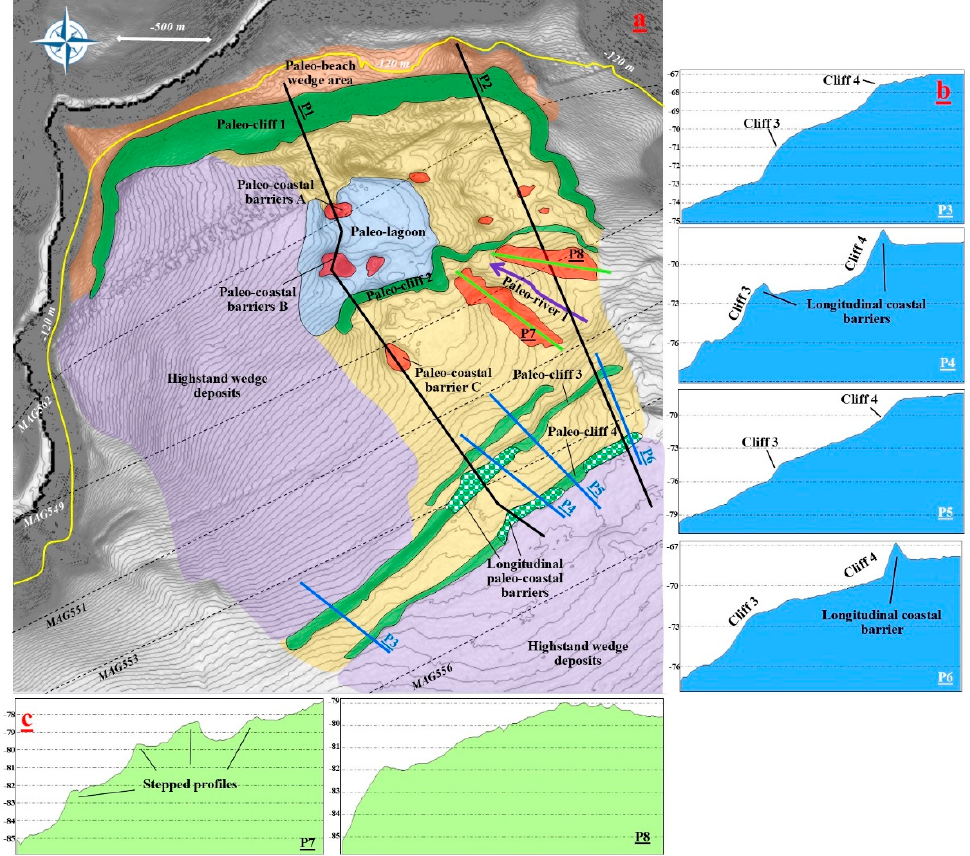
Figure 4. ( a ) Mapping of the main geomorphic elements outcropping on the seabed of the western sector of the study area, with particular focus on the relict Transgressive System Tract deposits. ( b ) The P3, P4, P5 and P6 bathymetric profiles, about orthogonal to paleo-cliffs 3 and 4. ( c ) The P7 and P8 bathymetric profiles about longitudinal to the paleo-river 1 delta.